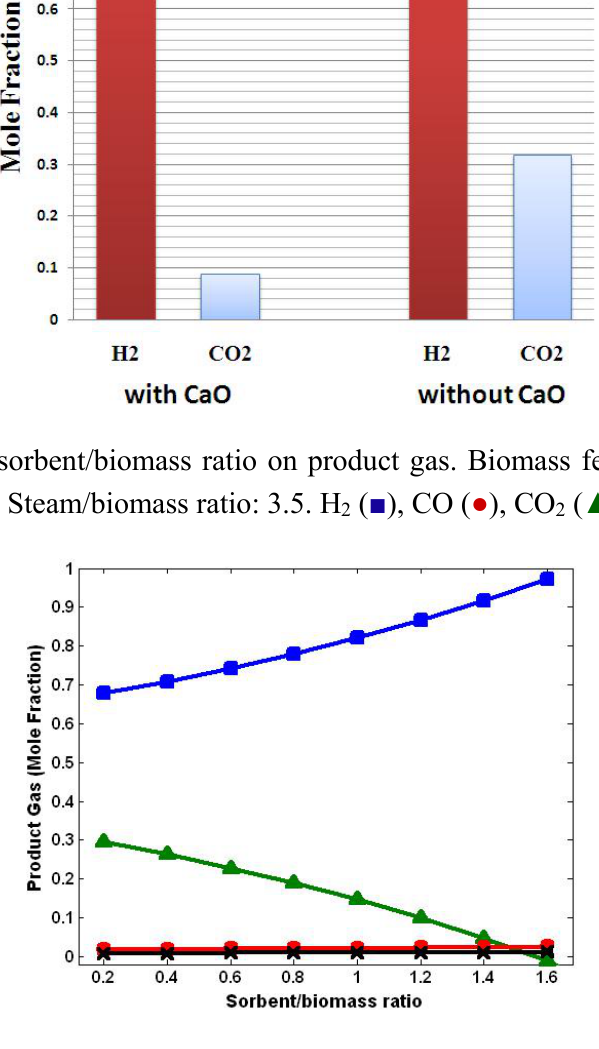
Figure 7. Effect of CaO on hydrogen and carbon dioxide. Biomass feed rate: 0.072 kg/h; Sorbent/biomass ratio: 1.2; Temperature: 950 K; Steam/biomass ratio: 3.0.